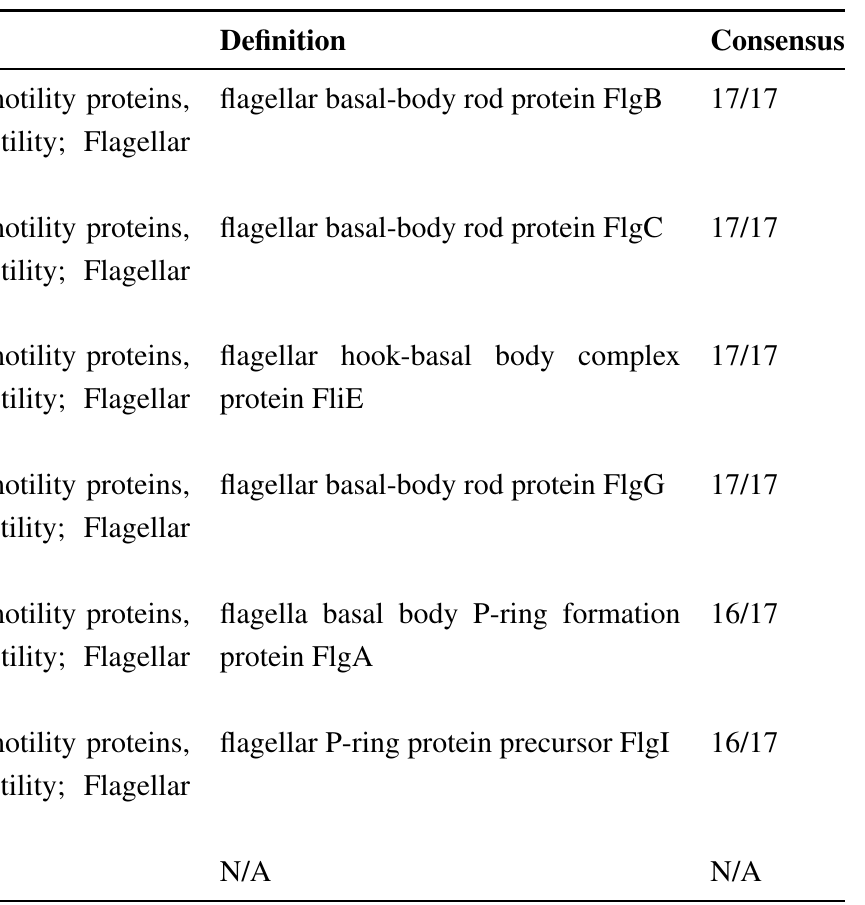
Table 2. Functional annotation of a particular reconstructed contiguous gene run in the LCA of the Rhizobiales group. Consensus column shows the number of genes that have been assigned with the corresponding annotation as well as the total number of genes in the family. Genes are sorted by the order on the